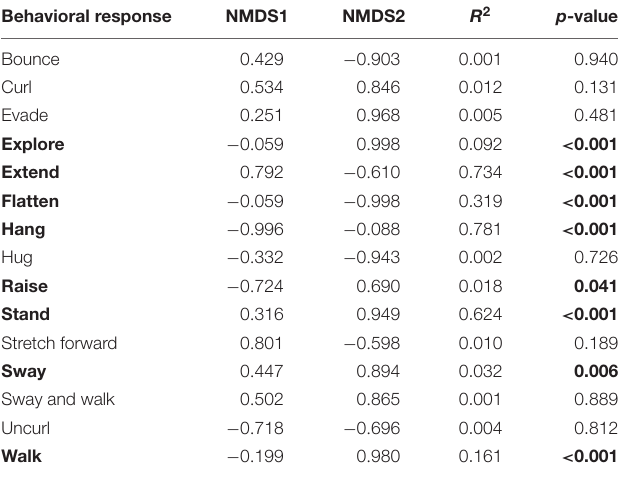
TABLE 2 | The contribution of individual behaviors to the non-metric multidimensional scaling (NMDS) data separation. Behavioral